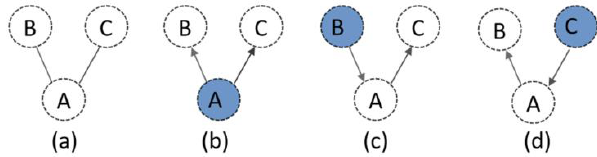
Figure 4. Printing sequence planning graph: ( a ) an undirected graph as the result of coarse decomposition, ( b ) a directed graph if the sequence start from node ‘A,’ ( c ) a directed graph if the